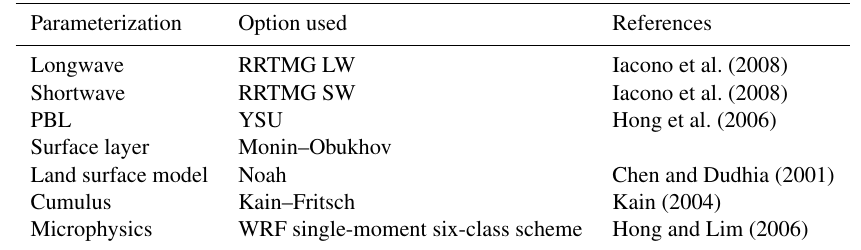
Table 1. MPAS-A CO 2 transport model